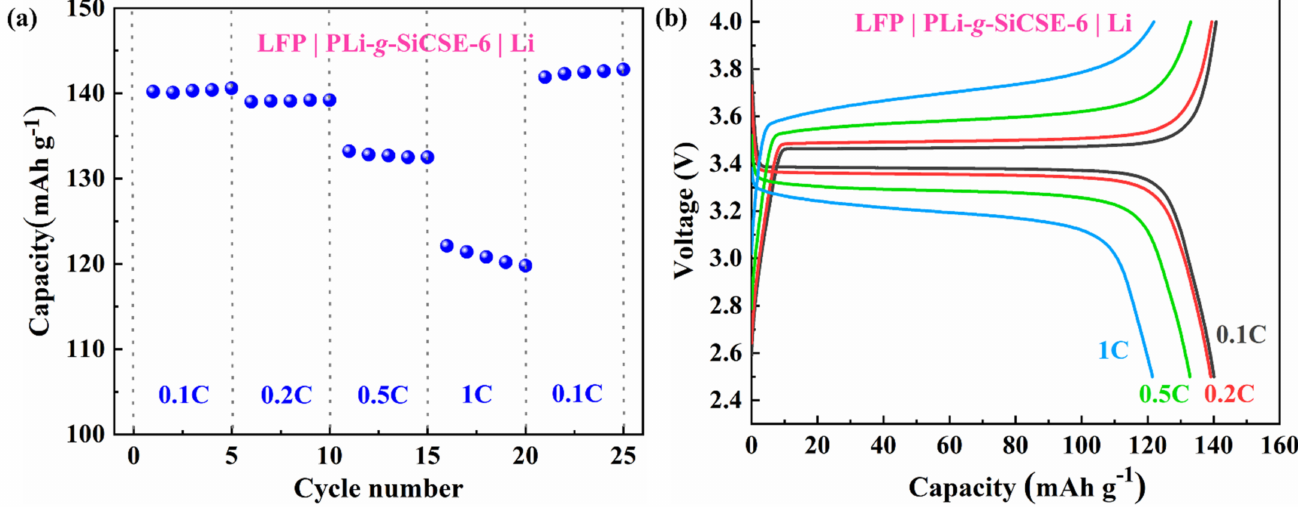
Figure 12. ( a ) Rate capability and ( b ) initial charge-discharge curves of LFP|PLi- g -SiCSE-6|Li batterie with various C